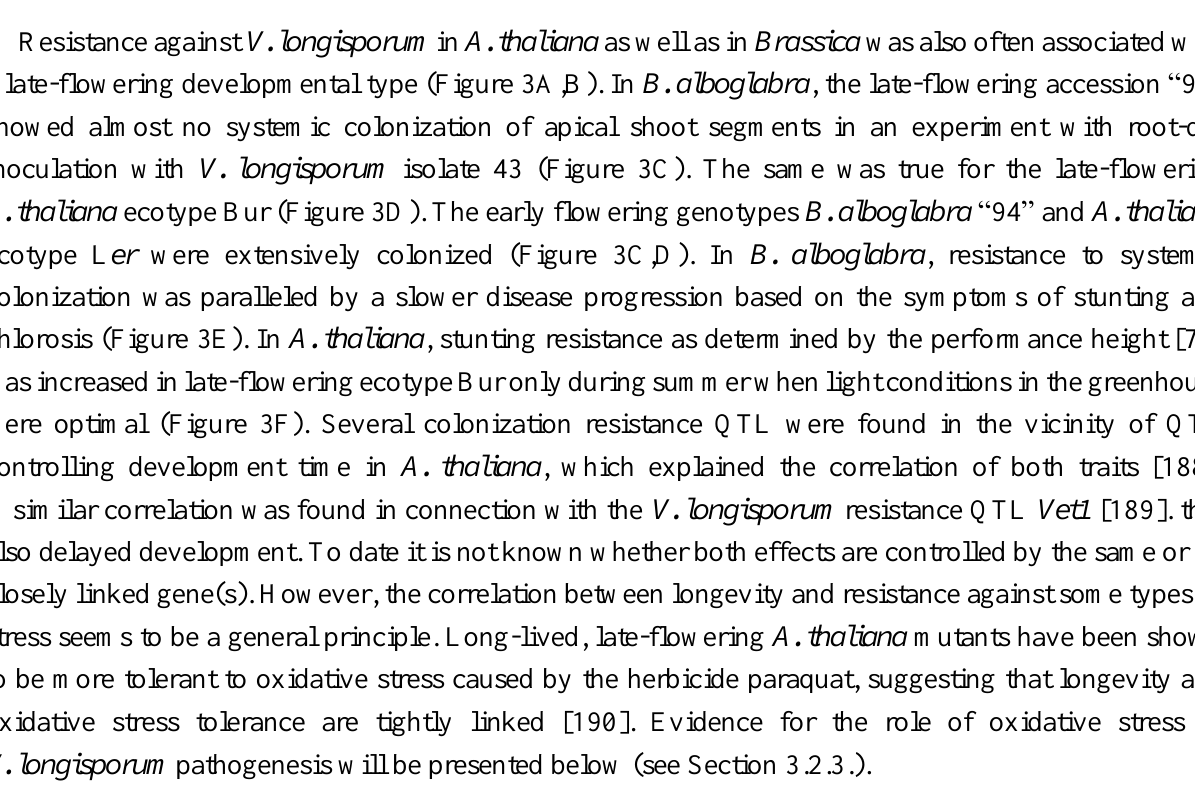
Figure 2. Systemic colonization of L er and Bur by V. longisporum in the course of plant development. Percentage of colonized apical shoot segments in a plating assay (closed symbols) and fungal DNA-content determined by qPCR in apical shoot segments (open symbols) in L er (circles) and Bur (squares) at different developmental stages. Developmental stages: 3 = 1–3 flowers open, 4 = 4–10 flowers open, 5 = more than 10 flowers open, 6 = up to 3 siliques mature, 7 = 4–6 siliques mature, 8 = up to 50% of siliques on main shoot mature. N = 4 (Bur) or 5 (L er ), one replicate corresponded to a batch of 30 plants. Error bars denote standard deviations (data from